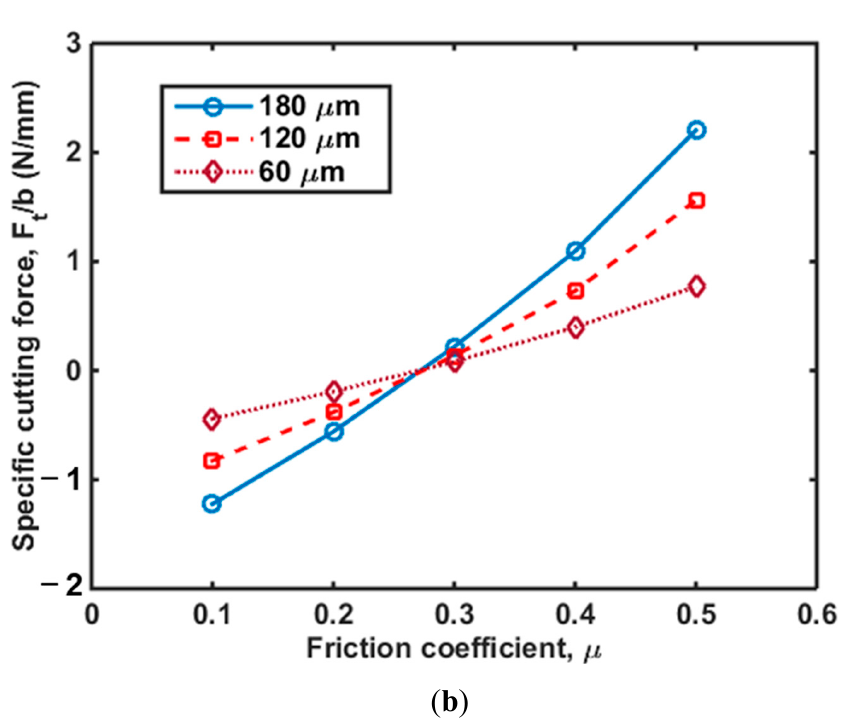
Figure 9. Cutting force in ( a ) cutting direction and ( b ) transverse direction as a function of friction coefficient in HDPE with a rake angle of 15°.